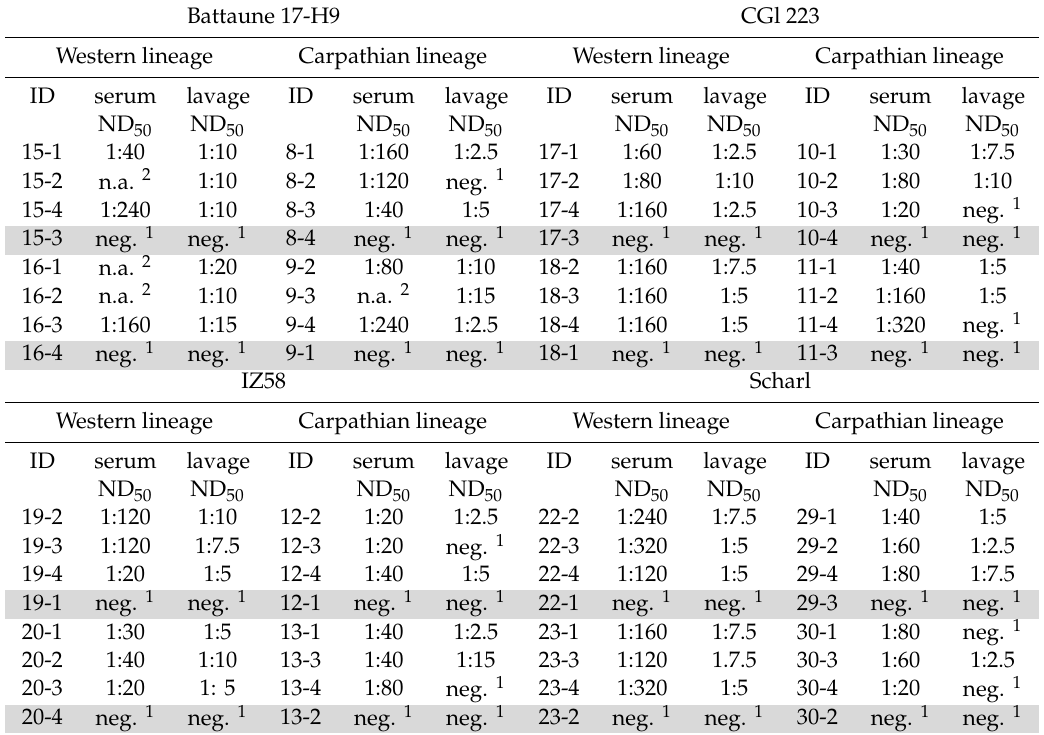
Table 4. Results of the microneutralization assay comparing the usage of lavage samples to serum samples for the Battaune 17-H9, CGl 223, IZ58, and Scharl strains. The bank voles of the Western linage are compared to the bank voles of the Carpathian lineage. Contact animals are shaded in